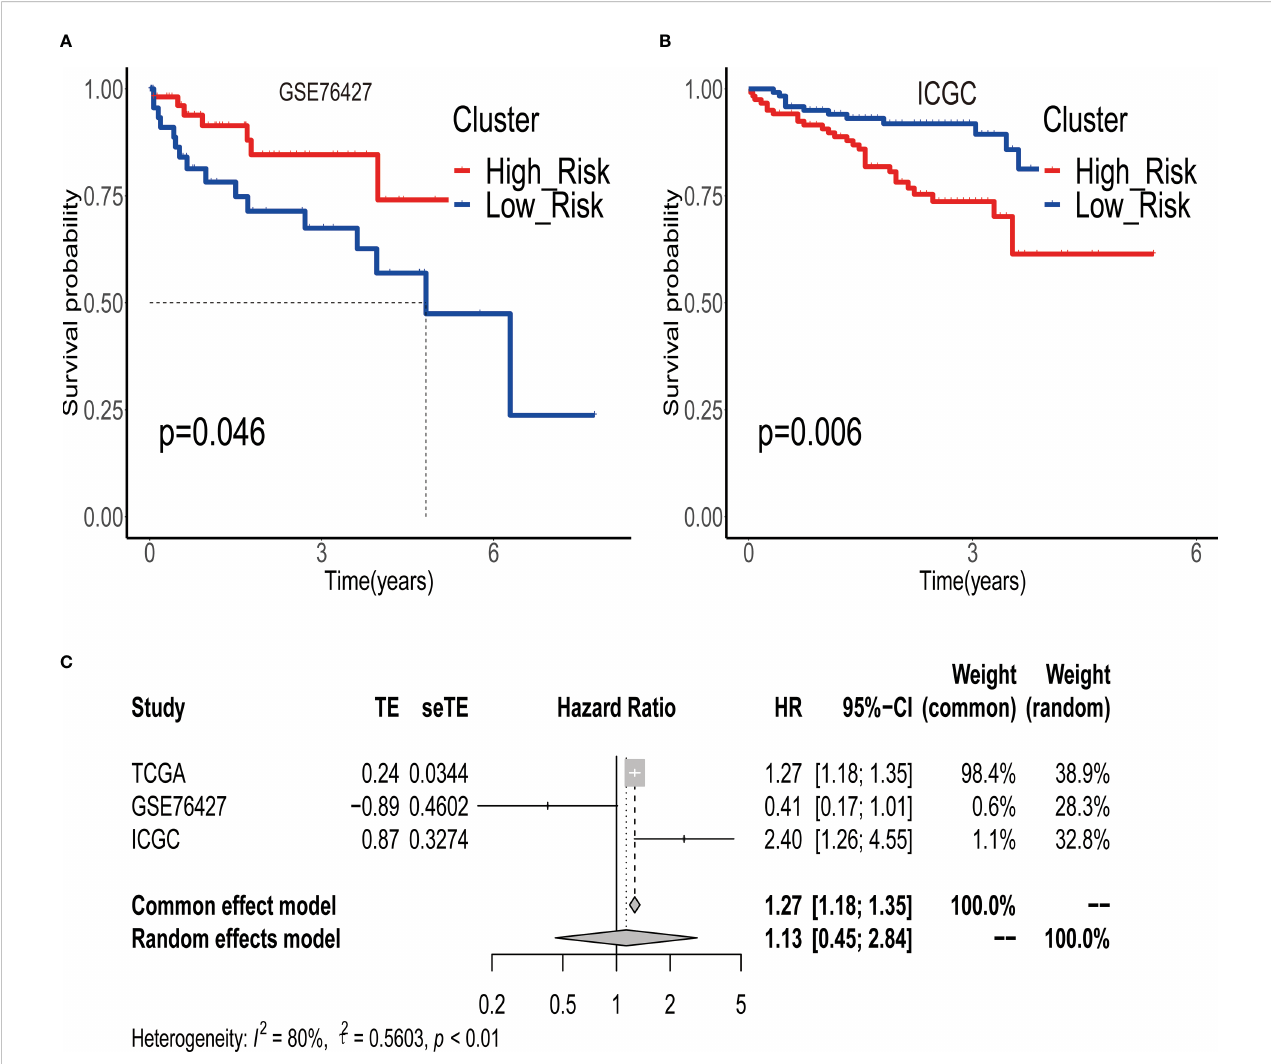
FIGURE 3 Validity of prognostic signature validated by multiple independent external datasets. (A) In the GSE76427 dataset, the overall survival time of patients in the high-risk group group was signi fi cantly better than that of patients in the low-risk group. (B) In the ICGC dataset, the overall survival time of patients in the high-risk group group was signi fi cantly better than that of patients in the low-risk group. (C) Results of meta-analysis con fi rm that prognostic signature is an independent risk factor affecting the prognosis of HCC